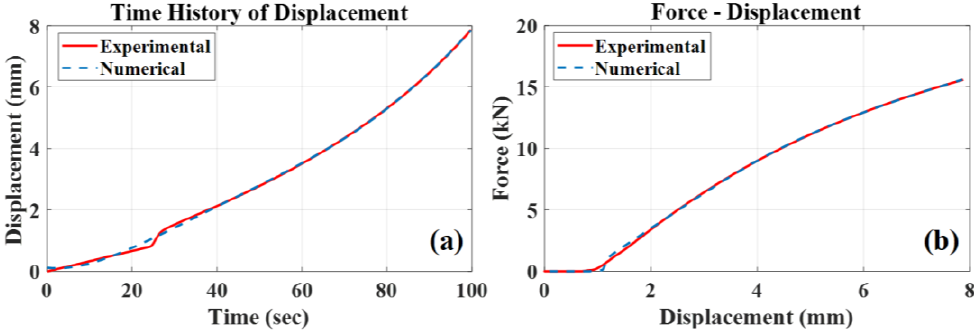
Figure 4. ( a ) Comparison of experimental and numerical of updated FEM time histories of displace- ment and ( b ) imposed force-displacement comparison between experiment and updated FEM analysis.